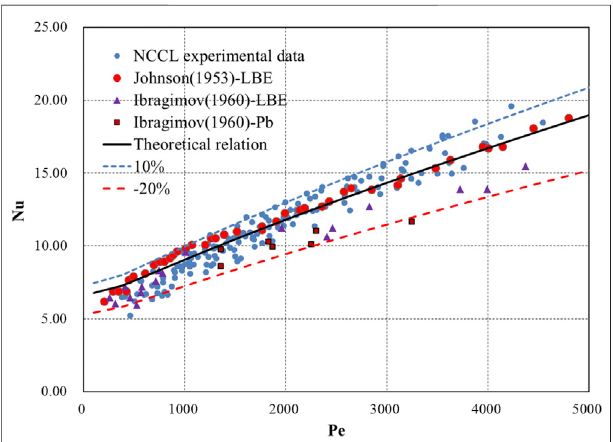
FIGURE 7 | Comparison of Eq. 20 with NCCL and literature experimental